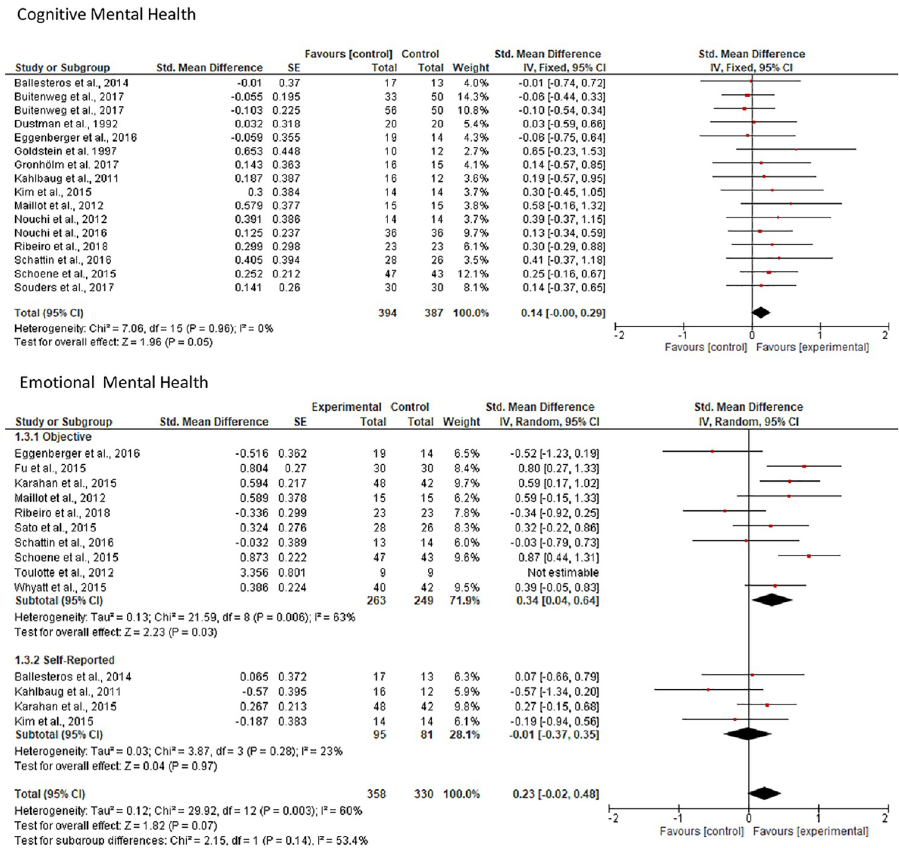
Fig 4. Forest plot of comparisons: Experimental vs. control group change in cognitive and emotional mental health.